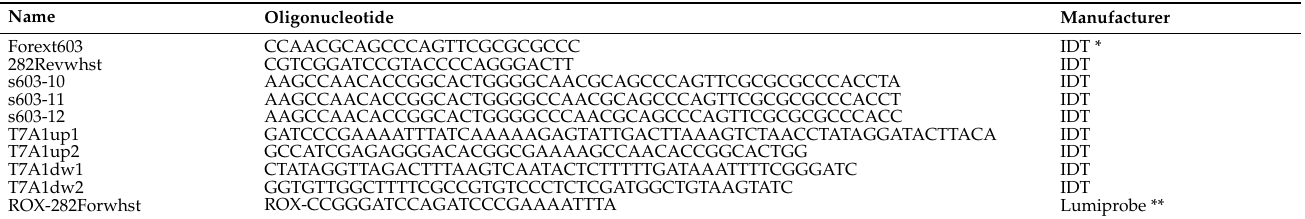
Table 1. Oligonucleotide sequences and